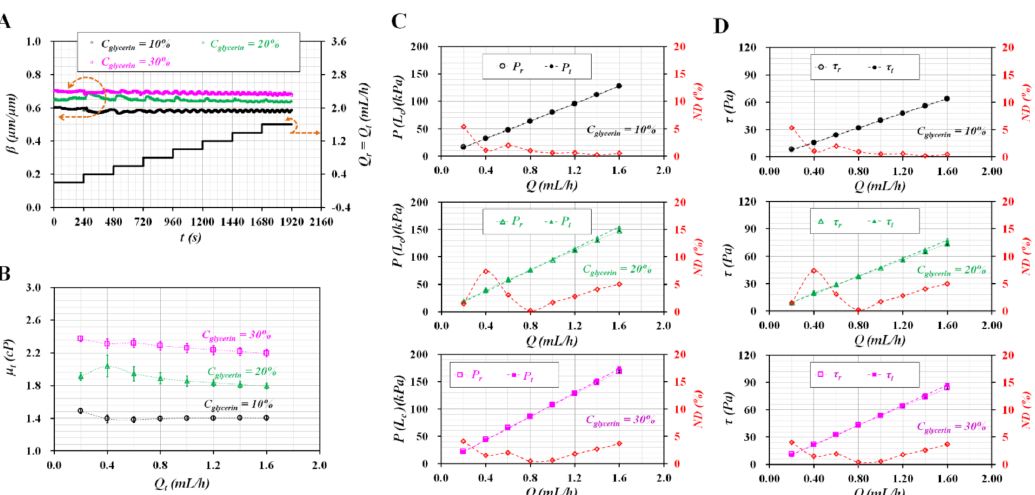
Figure 3. Quantitative comparison of pressure and shear stress for both streams at the same flow rate of two fluids. 1 × PBS was selected as reference fluid. While the flow rate of each fluid increased stepwise from 0.2 mL/h to 1.6 mL/h, both fluids were supplied into the microfluidic device at the same flow rate ( Q r = Q t ). ( A ) Temporal variation of β as well as flow rate ( Q r , Q t ) with respect to C glycerin = 10%, 20%, and 30%. ( B ) Variation of viscosity of test fluid (i.e., C glycerin = 10%, 20%, and 30%) with respect to Q t . ( C ) Variations of P r and P t and ND between both pressures with respect to C glycerin . ( D ) Variations of τ r and τ t for each stream and ND between both shear stresses with respect to C glycerin